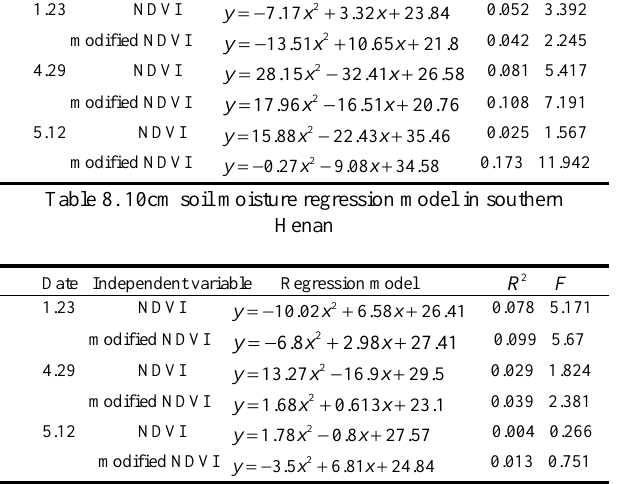
Table 9. 20cm soil moisture regression model in southern